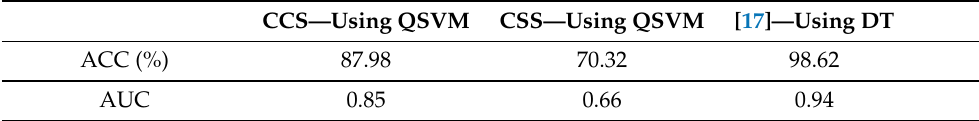
Table 2. Results from the CCS, CSS, and [17]